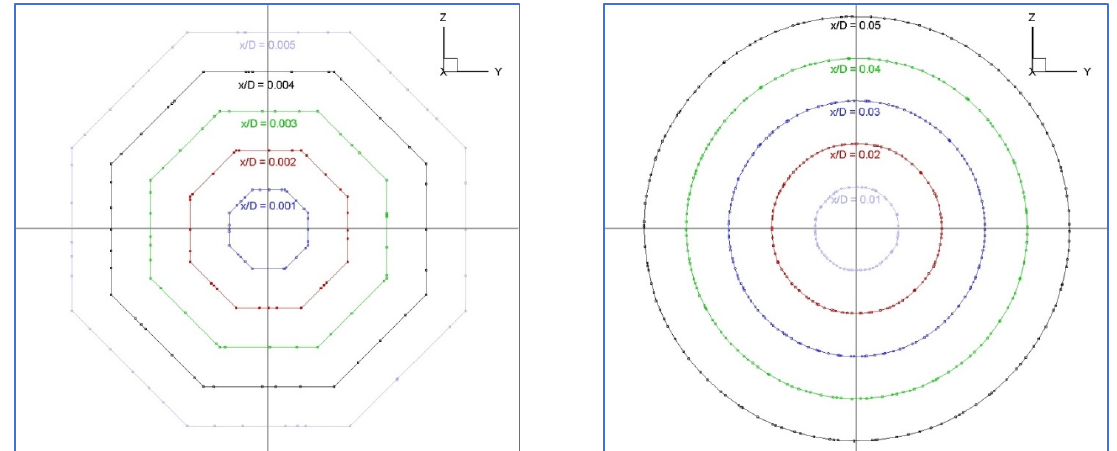
Figure 3. Surface mesh cross section of the unstructured grid at x/D = 0.001 to x/D = 0.005 ( left ) and x/D = 0.01 to x/D = 0.05 ( right ).